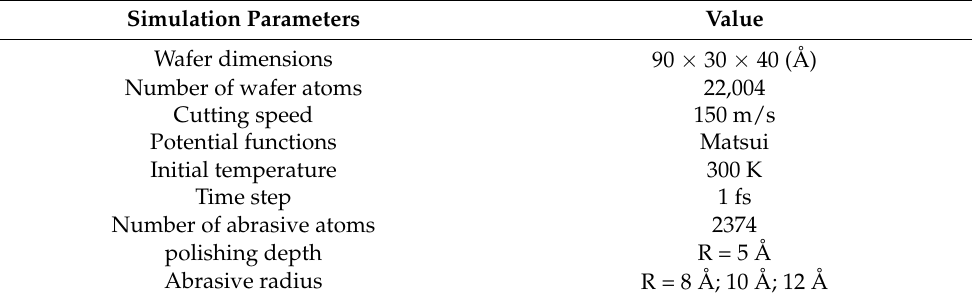
Table 1. Simulation model parameters of different abrasive particle radii.